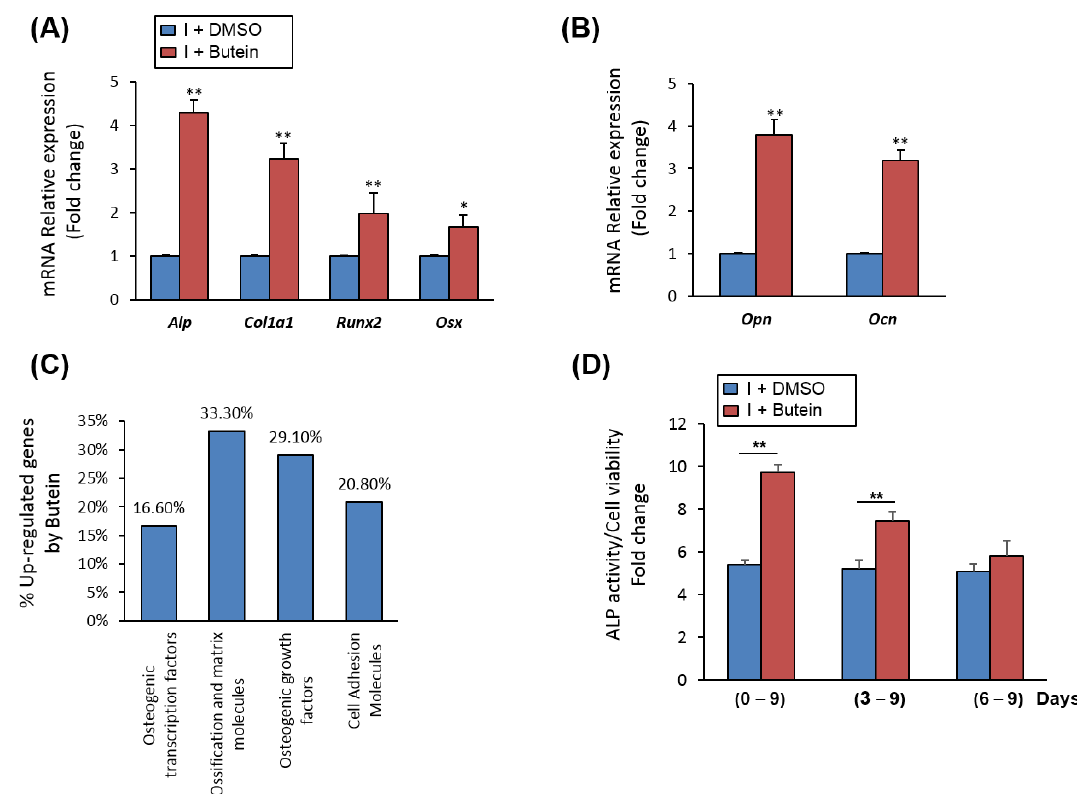
Figure 2. Butein stimulates the upregulation of osteoblast-related gene expression. ( A ) Butein upregulated the gene expression of early and ( B ) late osteogenic markers in mBMSCs during osteogenesis. Cells were induced to osteoblast differentiation for 12 days in the absence (I + DMSO) or the presence of butein (I + butein, 30 µ M). Expression of each target gene was normalization to the reference genes and represented as a fold change over differentiated cells without butein. ( C ) Upregulated osteoblast-related genes by butein in mBMSCs as measured by qPCR-based osteogenic gene array analysis. Upregulated genes by butein were categorized according to their osteogenic functions. ( D ) Treatment of mBMSCs with butein at different stages during osteoblast differentiation. Cells were induced to differentiate into osteoblasts and then treated with DMSO (I + DMSO) or butein (30 µ M) at day1, day3 and day6 of osteogenesis. ALP activity staining was performed after 9 days for all treatments. Values are mean ± SD of three independent experiments, (* p < 0.05, ** p < 0.005 compared to differentiated cells without butein). Table 1. List of upregulated osteogenic-related genes by butein in mBMSCs as measured by mouse osteogenesis RT 2 Profiler™ PCR array analysis.